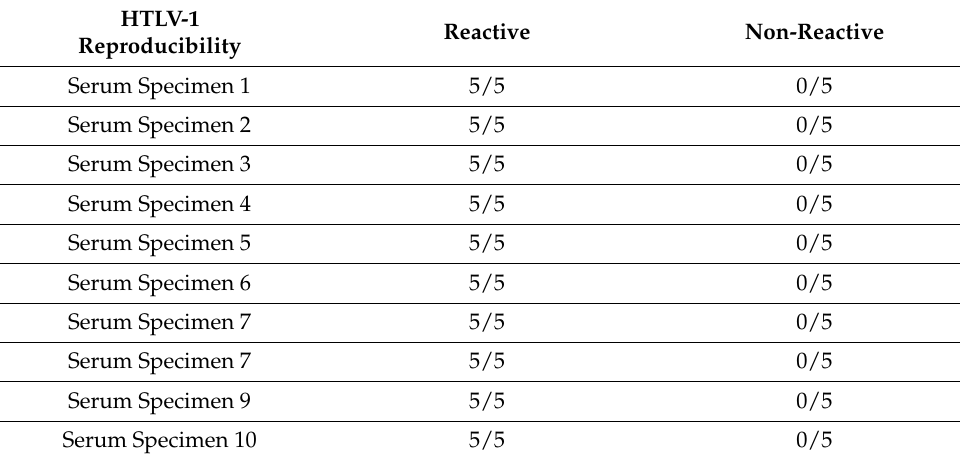
Table 4. Reproducibility studies with HTLV-I serum